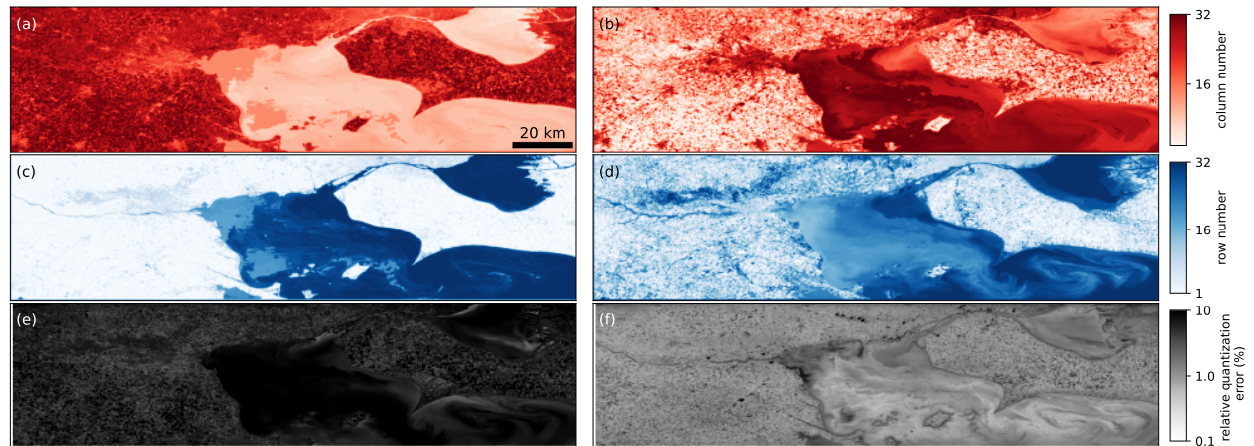
32 5 SOM calculated from the first North Sea scene × ×